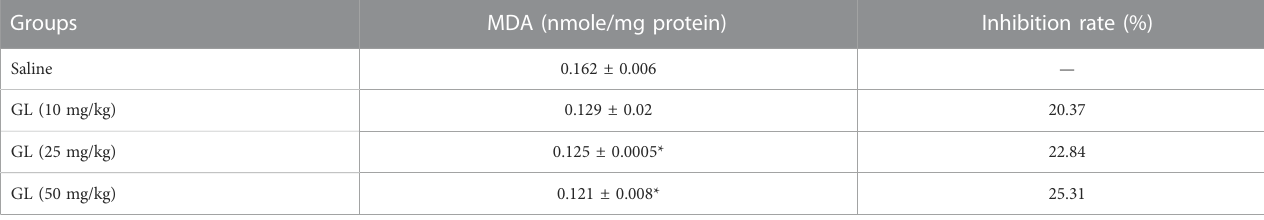
TABLE 3 Effect of G. lucidum extracts (GL) on lipid peroxidation in mouse (untreated with ethanol) liver homogenates. Groups